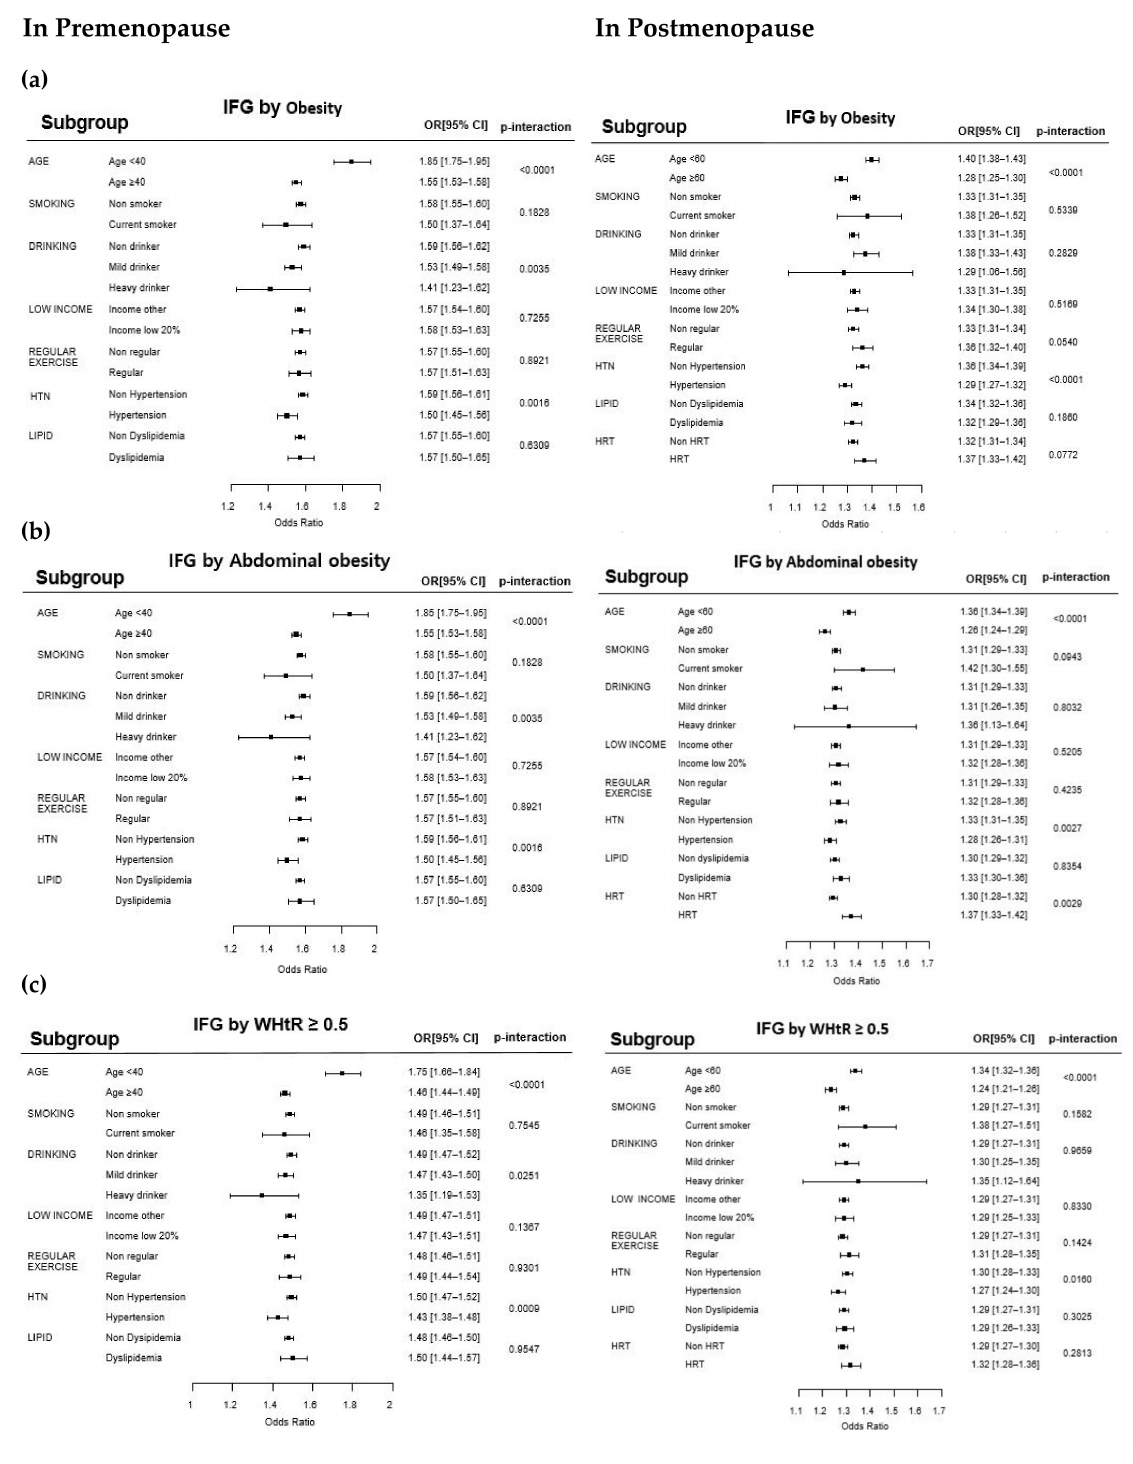
Figure 3. Forest plots of the odds ratios of impaired fasting glucose from various subgroup analyses in relation to different obesity criteria in the pre- and postmenopausal groups. ( a ) Subgroup analysis in obesity (BMI ≥ 25 kg/m 2 ) group. ( b ) Subgroup analysis in abdominal obesity (WC ≥ 85 cm) group. ( c ) Subgroup analysis in WHtR ≥ 0.5 group. Note: Data were obtained using multivariate logistic regression models of SAS software version 9.4. The R software version 3.5.1 was employed to generate forest plots for subgroup analyses. IFG, impaired fasting glucose; OR, odds ratio; CI, confidence interval; WHtR, waist-to-height ratio; HTN, hypertension; LIPID, dyslipidemia; HRT, use of hormone replacement